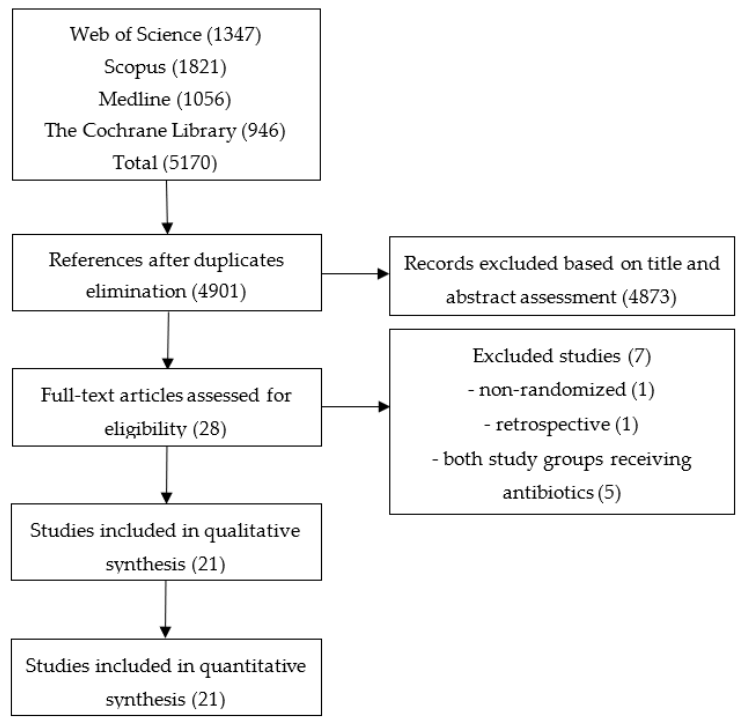
Figure 1. Flowchart illustrating the literature search and study selection.